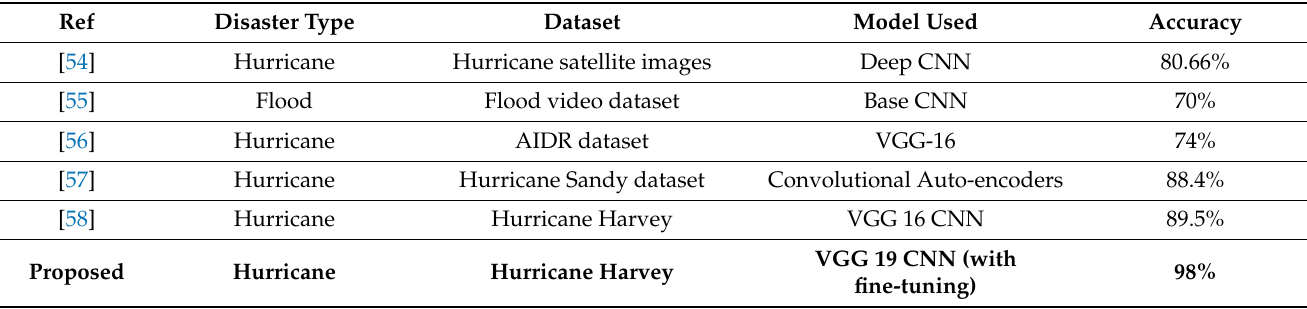
Table 9. Comparative analysis of existing models.